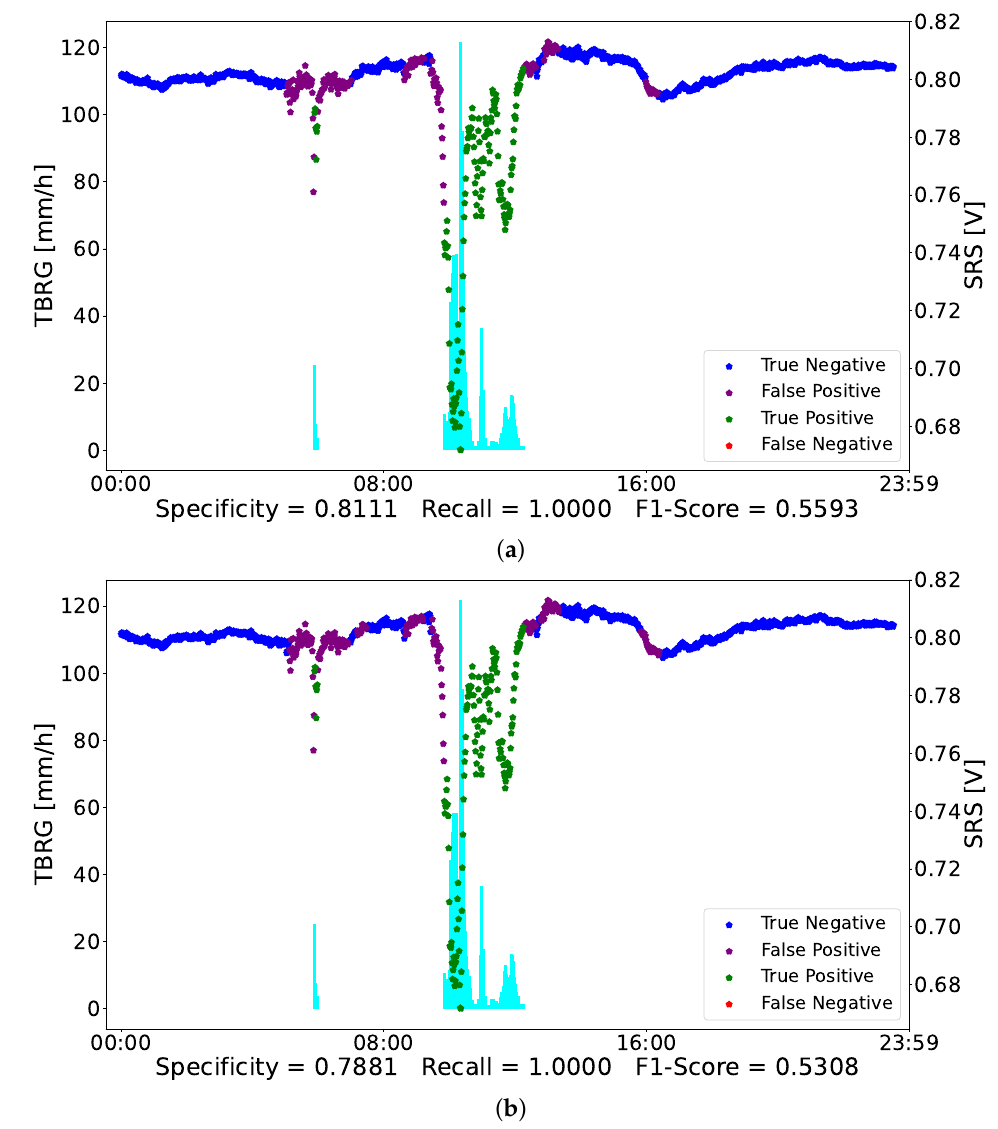
Figure 5. Day 17 classified by NN trained with 12 features ( a ) and with 6 features ( b ). The blue dots refer to not-rainy observations correctly classified, the purple ones are not-rainy observations classified as rain, the green ones are rainy observations correctly classified, and the red dots represent rainy observations classified as not rain. The cyan bars represent the TBRG measurements different from 0 mm/h, i.e., associated with the rain observations. ( a ) Day 17 Neural Network 12 Features. ( b ) Day 17 Neural Network 6